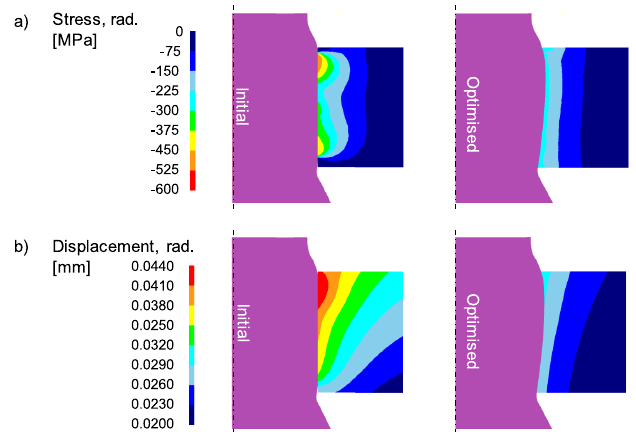
Fig. 5. (a) Radial stress and (b) radial displacement of the initial and optimised inner hub